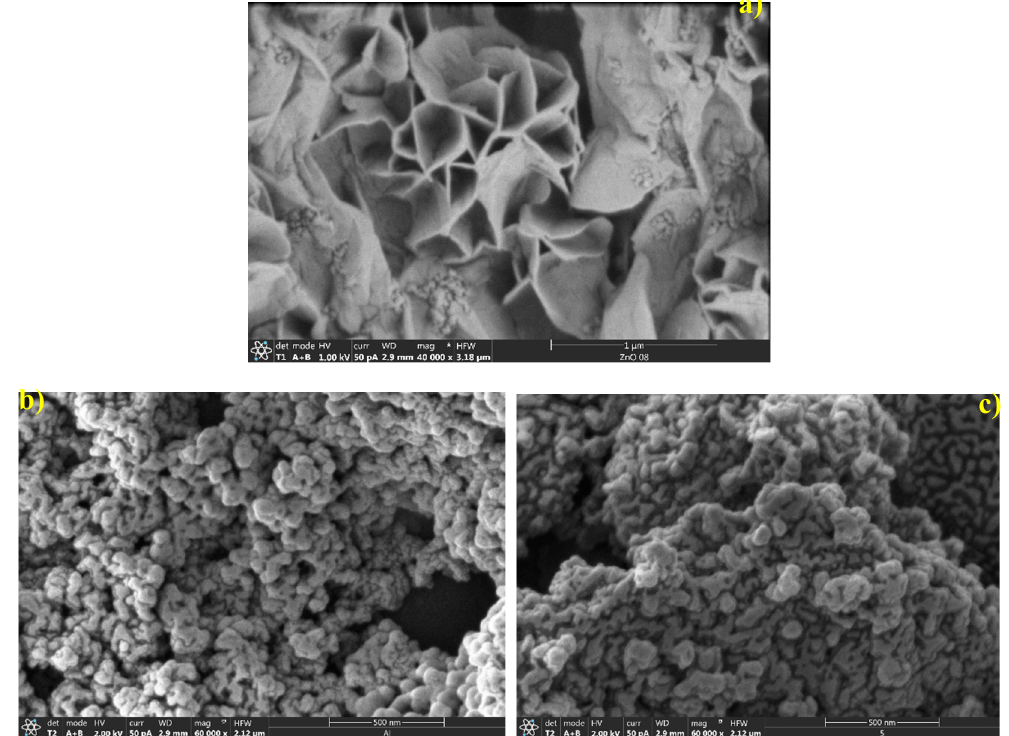
Figure 5. Field emission SEM (FESEM) images showing the morphology of nanocrystalline ( a ) ZnO, ( b ) ZnO–Al, and ( c ) ZnO–Ni.